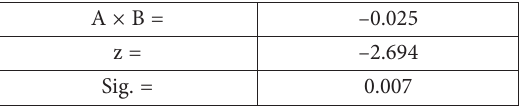
Table 8. Sobel test (indirect effect) (source: own research) A × B = –0.025 z = –2.694 Sig. =